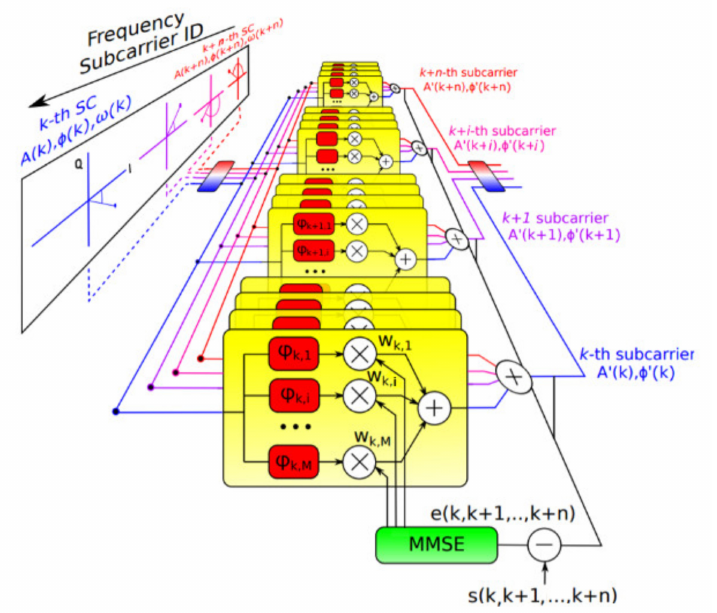
Figure 26. The architecture of MIMO deep learning equalizer.